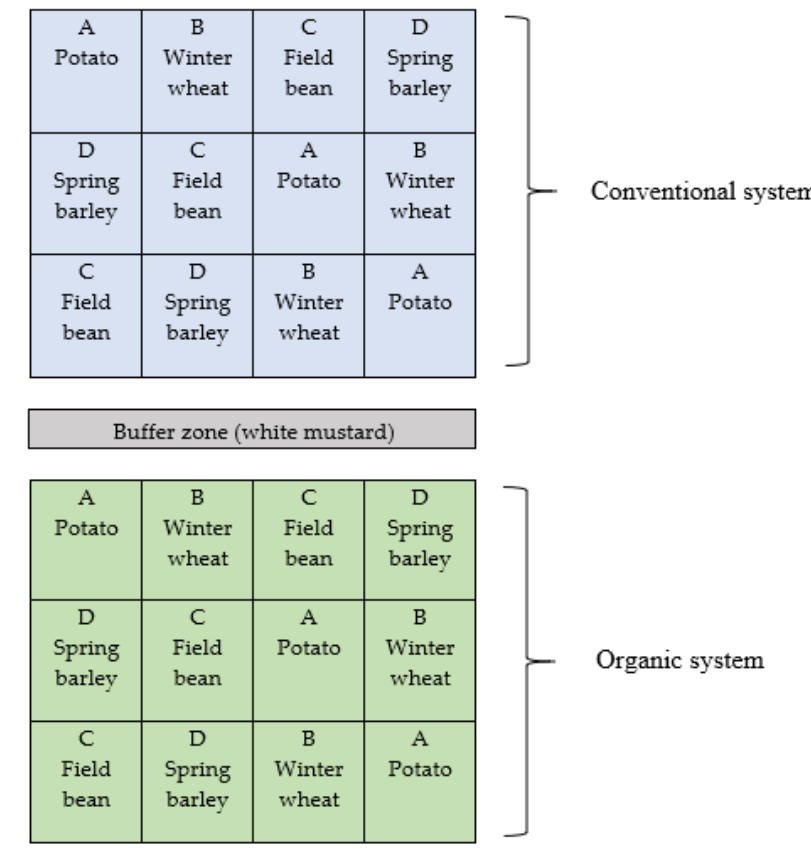
Figure 1. Design of the field experiment.